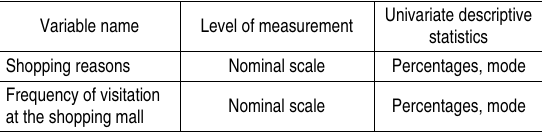
Table 1. Variables used in the data